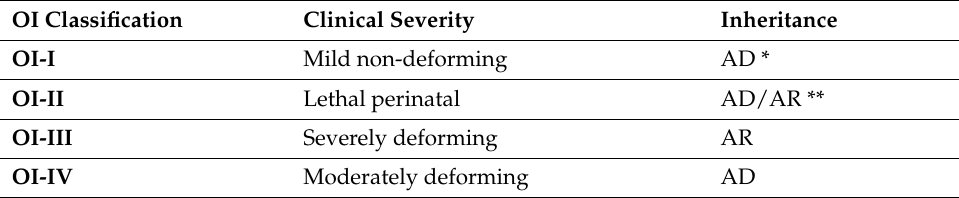
Table 2. Clinical–radiographic classification of OI [23,24].